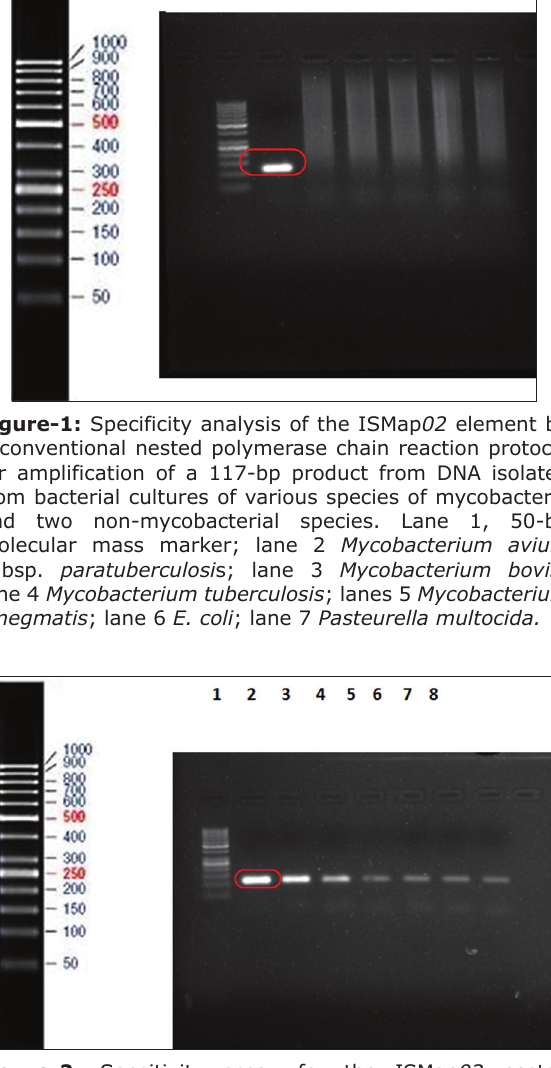
Figure-2: Sensitivity assay for the ISMap 02 nested polymerase chain reaction giving a product size of 117 bp. Lane 1 is 50 bp DNA marker and lane 2-8 consist of 1:10 serial dilutions of the standard Mycobacterium avium subsp. paratuberculosis genomic